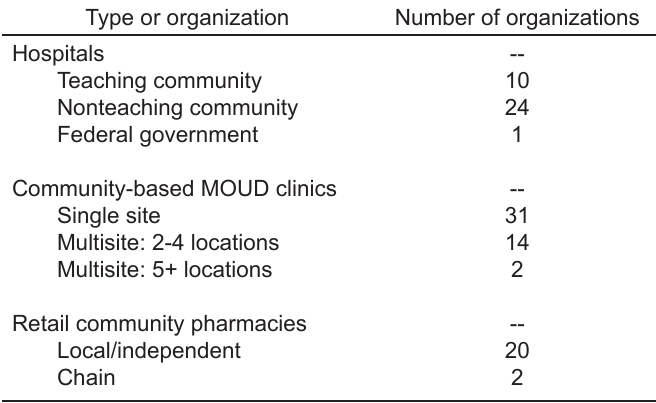
Table 3. Characteristics of organizations participating in the New York MATTERS*